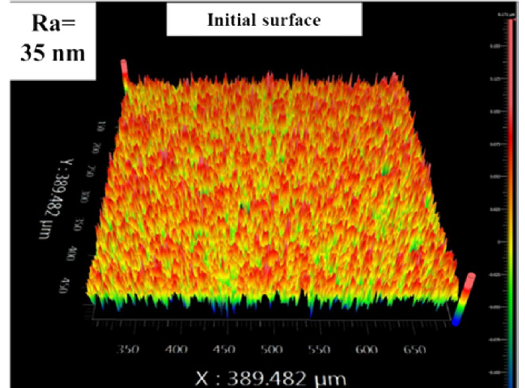
Figure 2. Initial surface topography: The surface asperities distribution is uniform and the surface roughness is 35 nm after grinding using a diamond slurry on a brass grading plate.